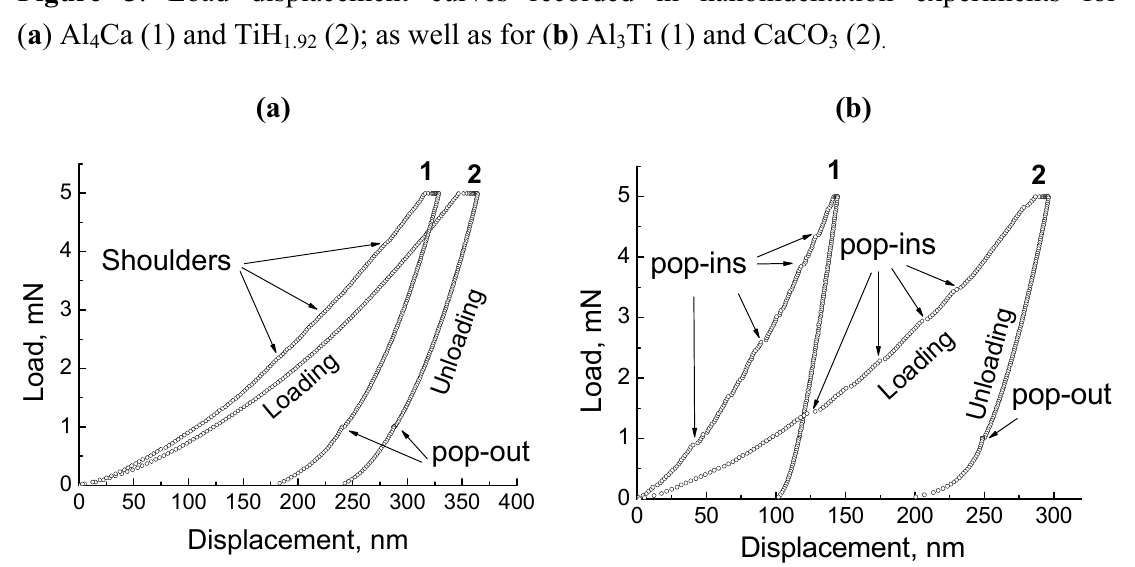
Figure 3 . Load displacement curves recorded in nanoindentation experiments